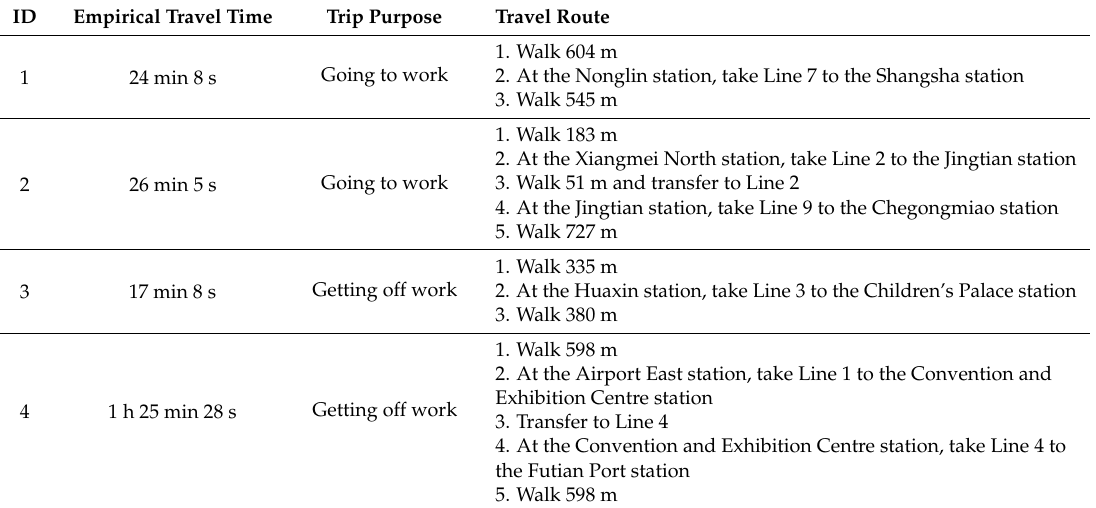
Table 1. Information on the metro travel routes of person